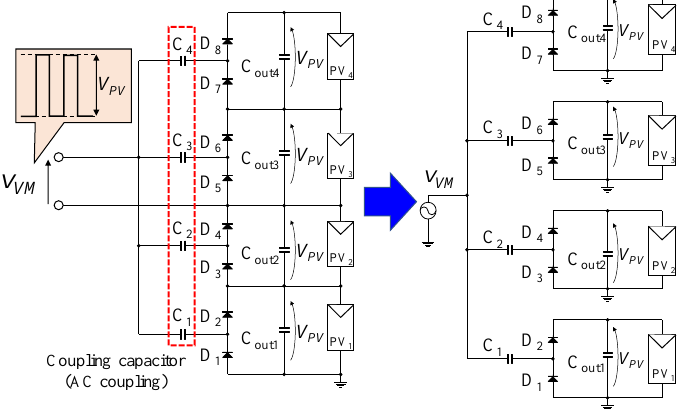
Figure 10. VM and its equivalent circuit.